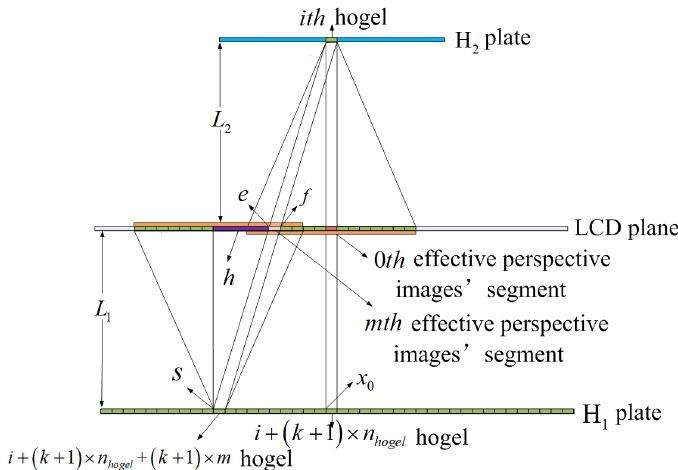
Figure 8. Diagram of effective perspective images